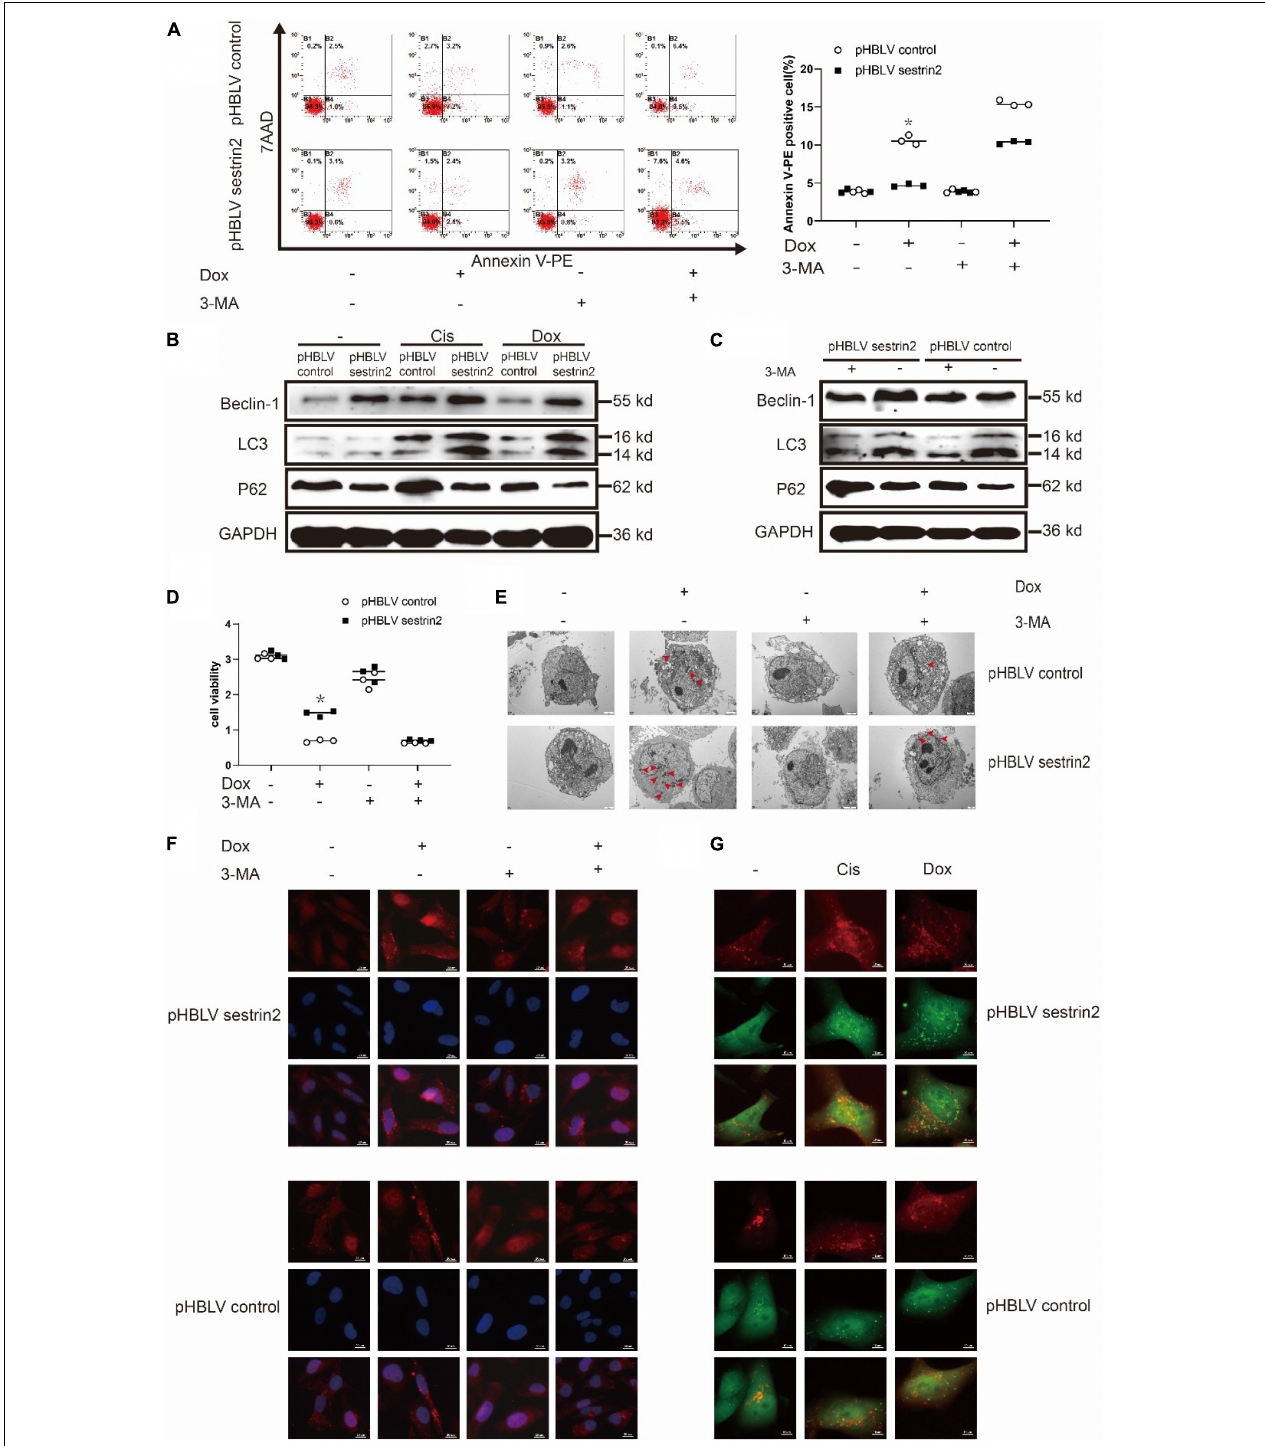
FIGURE 4 | SESN2 regulates autophagy and reduces the sensitivity of osteosarcoma cells to chemotherapy. In the presence or absence of 3-MA (5 mM), SESN2-overexpressing and control HOS cells were treated with Dox (0.2 µ g/mL) for 24 h, and apoptosis was analysed by flow cytometry (A) ( n = 3). After treatment with Cis (20 µ mol/L) or Dox (0.2 µ g/mL), the expression levels of LC3 and P62 in SESN2-overexpressing and control HOS cells were detected by western blot (B) ( n = 3). The expression levels of LC3 and P62 in SESN2-overexpressing and control HOS cells treated with 3-MA (5 mM) were detected by western blot (C) ( n = 3). In the presence or absence of 3-MA (5 mM), SESN2-overexpressing and control HOS cells were treated with Dox (0.2 µ g/mL) for 24 h, cell activity was detected by